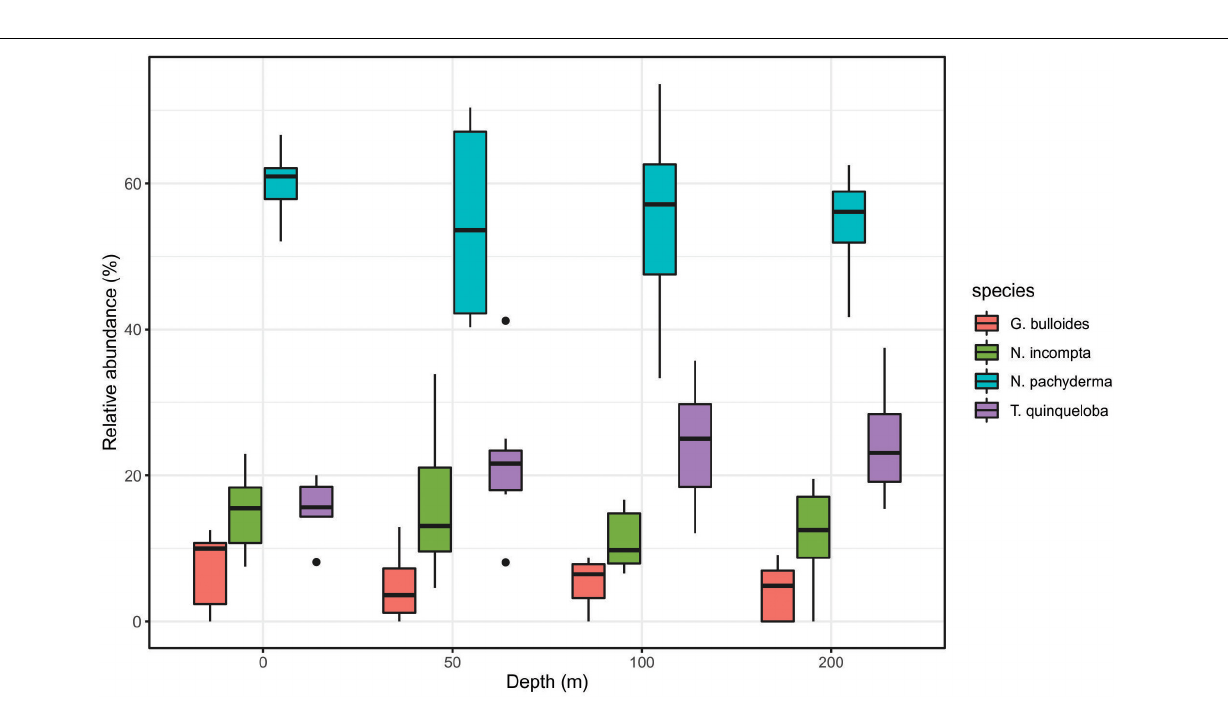
FIGURE 6 | Relative (%) species distribution of planktic foraminifera relative to water